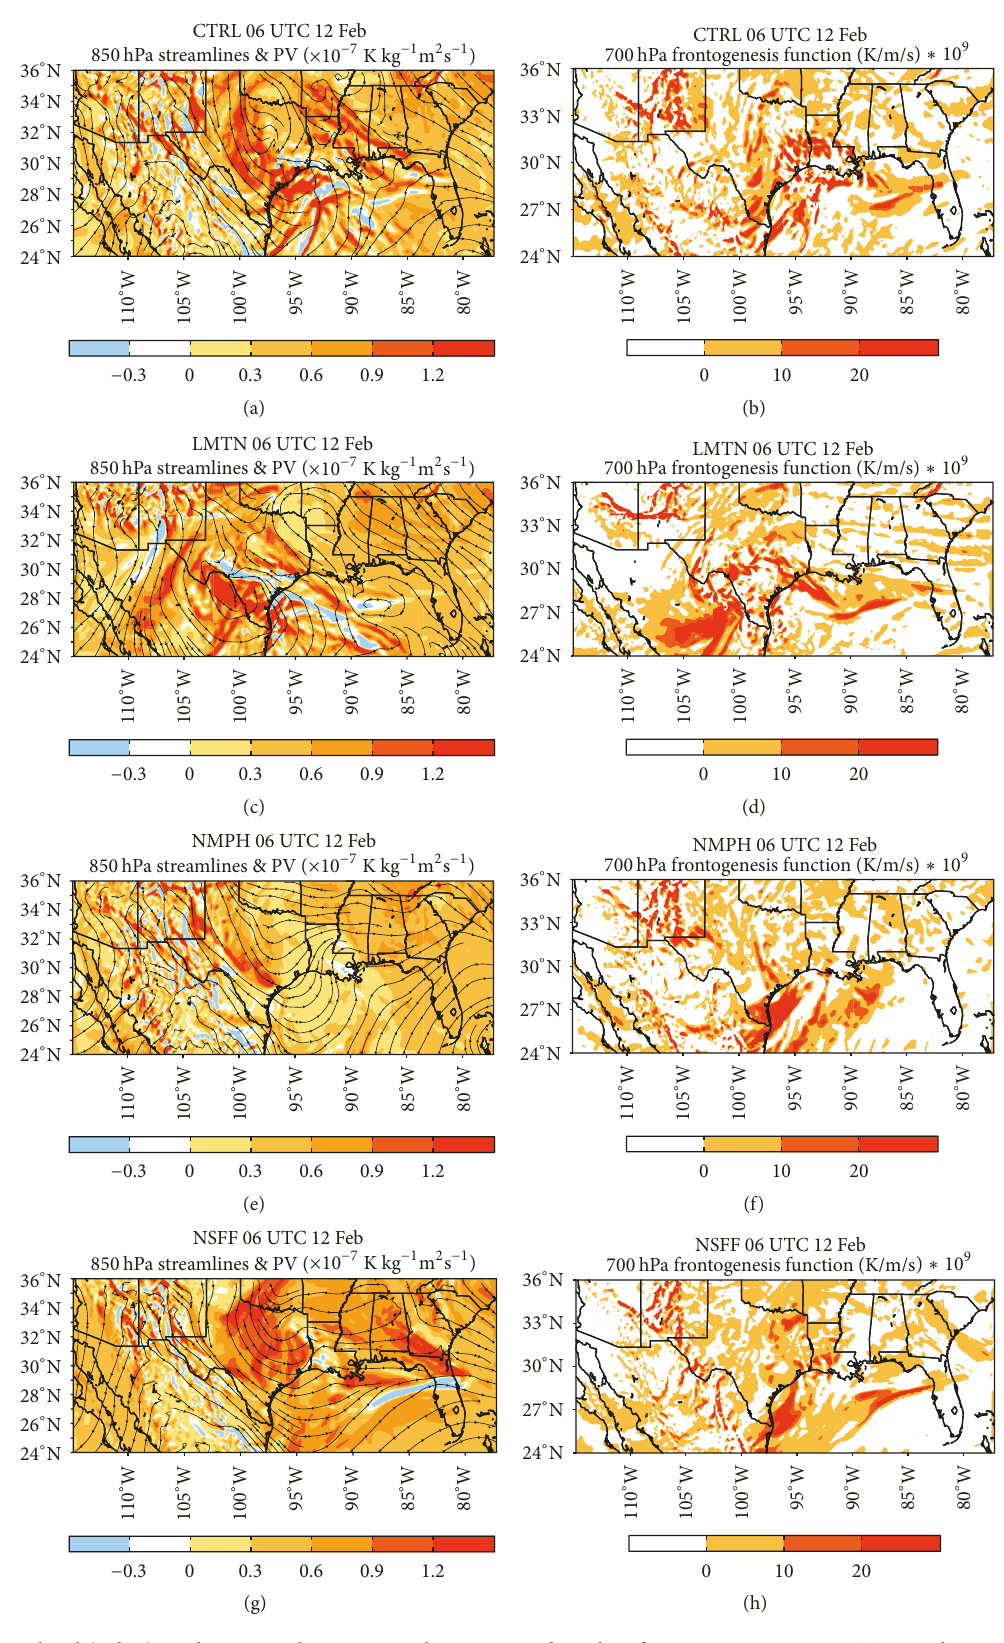
Figure 20: Simulated (12km) 850 hPa streamlines, potential vorticity, and 700 hPa frontogenesis on 0600 UTC 12 February 2010 for (a-b) control experiment, (c-d) terrain reduction experiment, (e-f) no microphysics heating experiment, and (g-h) no surface flux